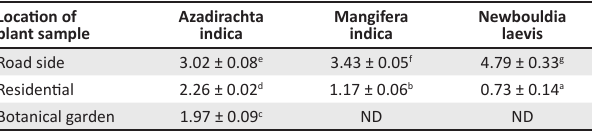
TABLE 2: Chromium concentration (ppm) in selected medicinal plants across locations within the University of Ibadan. Location of plant